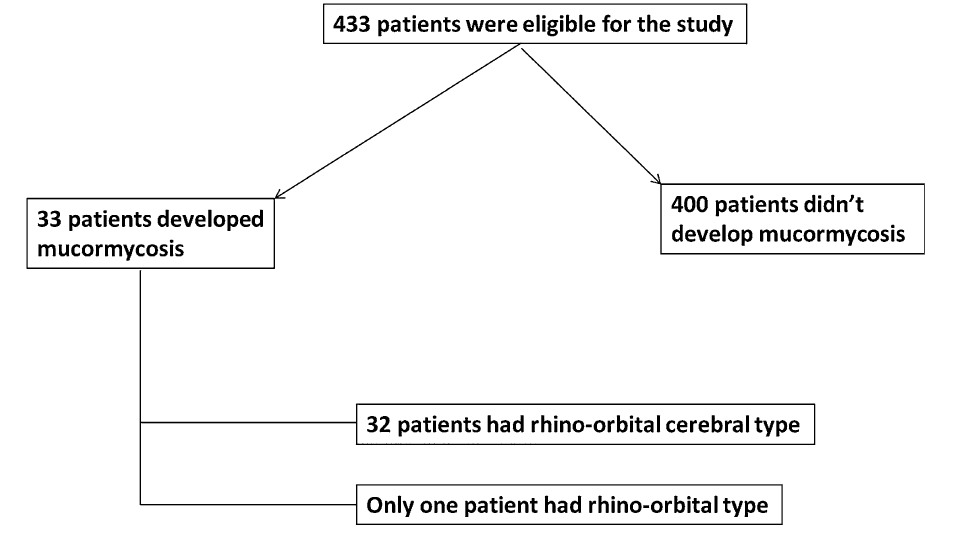
Figure 2. Flow chart of the studied population.